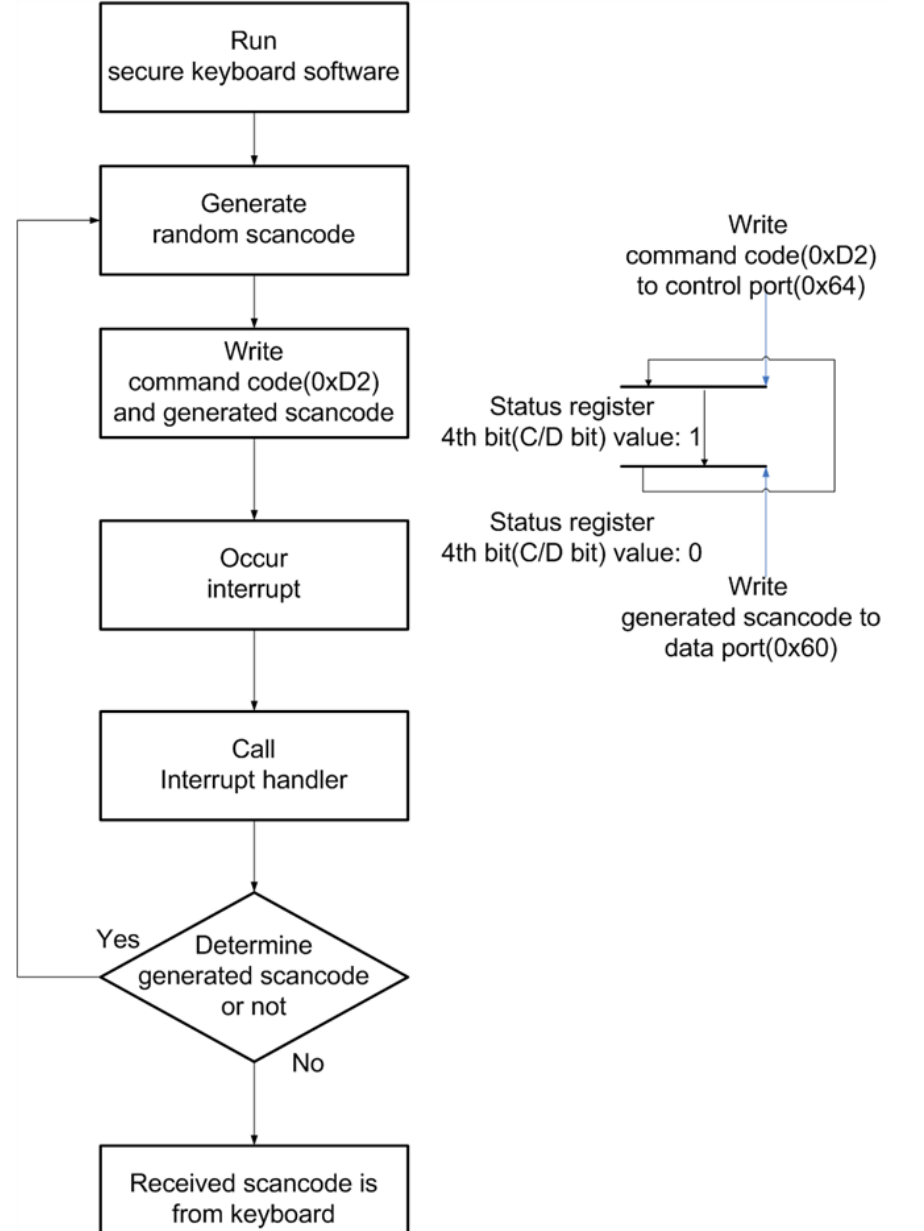
Figure 9. The process of the countermeasure for which mingling-noise scan codes are applied .